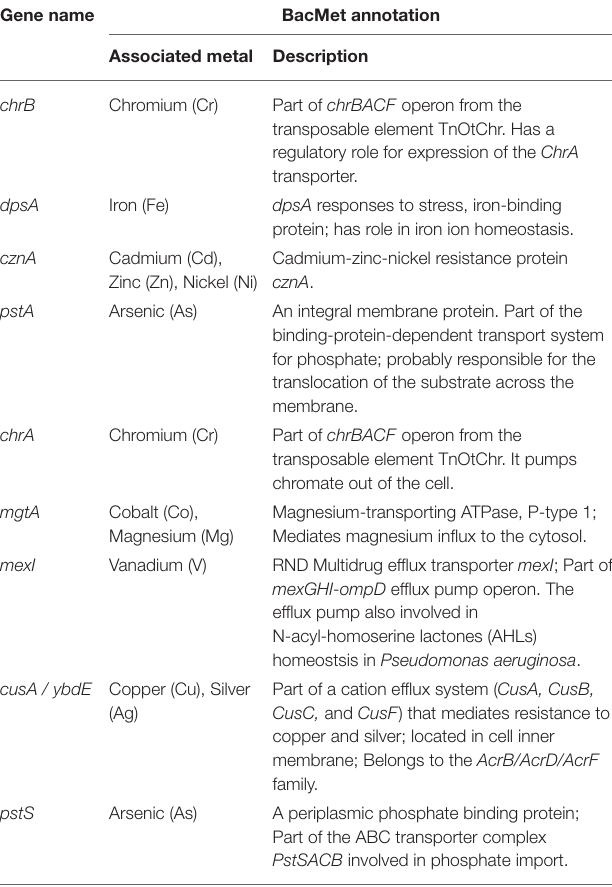
TABLE 4 | Metal-associated genes with higher predicted abundance in metal-rich Site B over Site A.